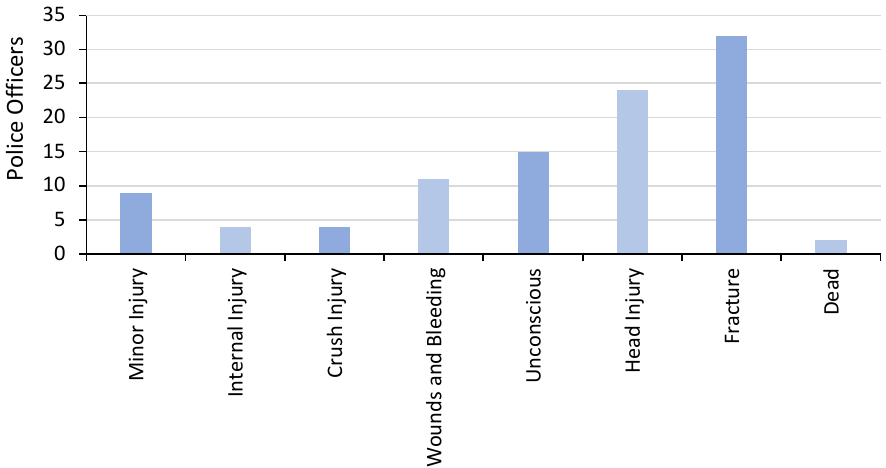
Figure 1. Road Traffic Injuries Transported to Hospital by Traffic Police in the Study District.